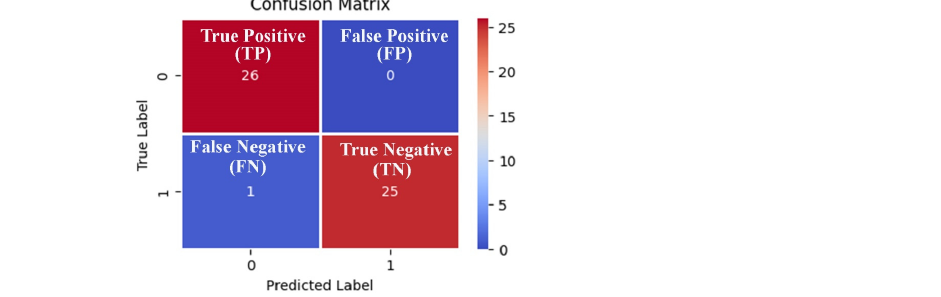
Figure 6. Confusion matrix-based visualization and summarization of the XGBoost-based classification model performance tested on the 20% independent test data generated using the three features obtained from the EO metaheuristic algorithm.